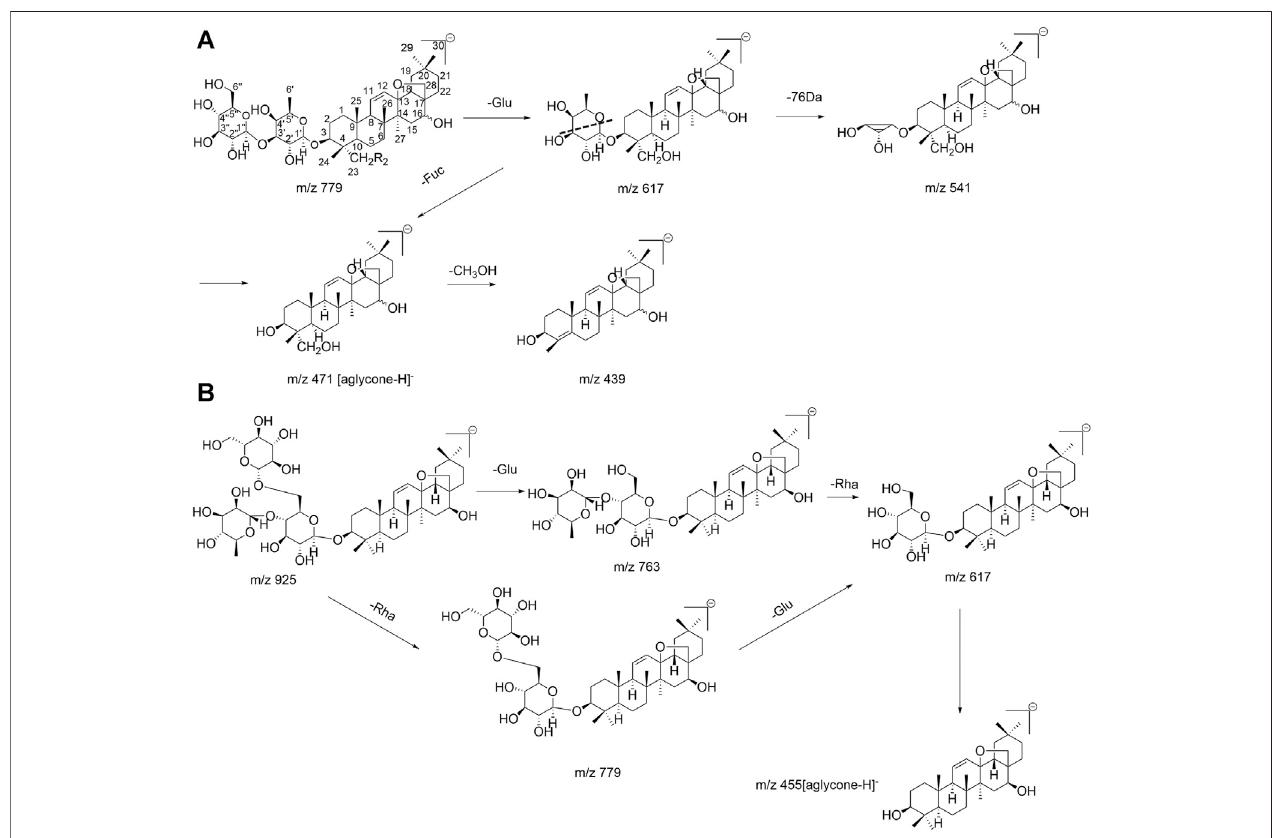
FIGURE 2 | Fragmentation pathway of (A) SSa/d and (B)